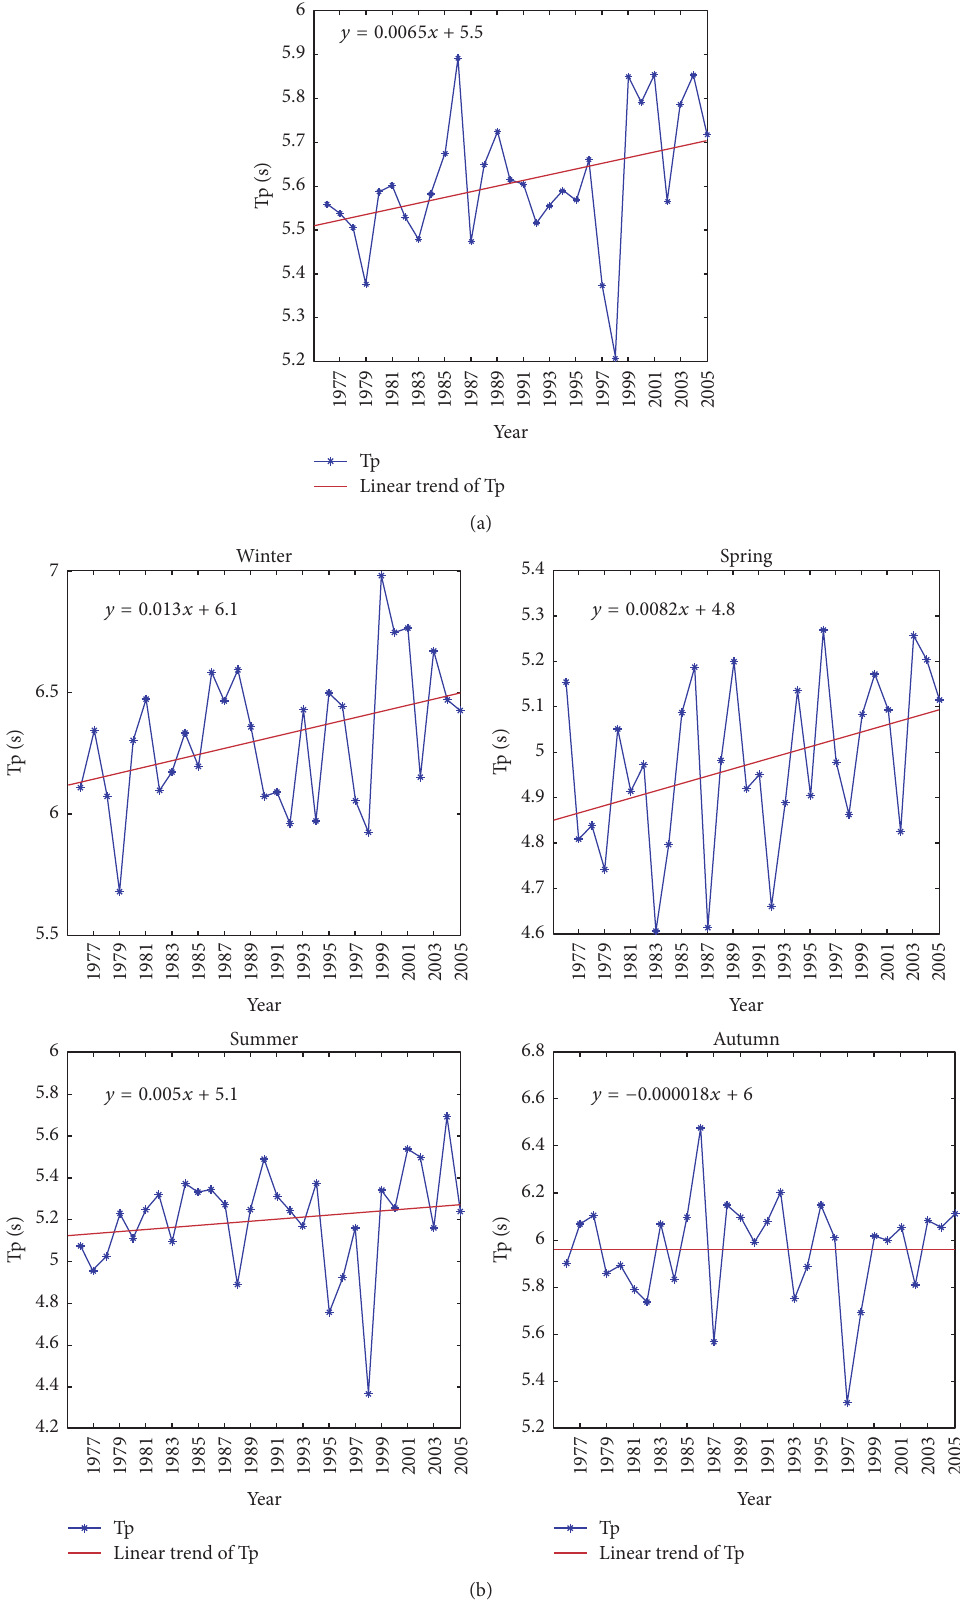
Figure 8: (a) Linear trend of annual mean Tp from year 1976 to year 2005. (b) Linear trends of seasonal mean Tp from year 1976 to year